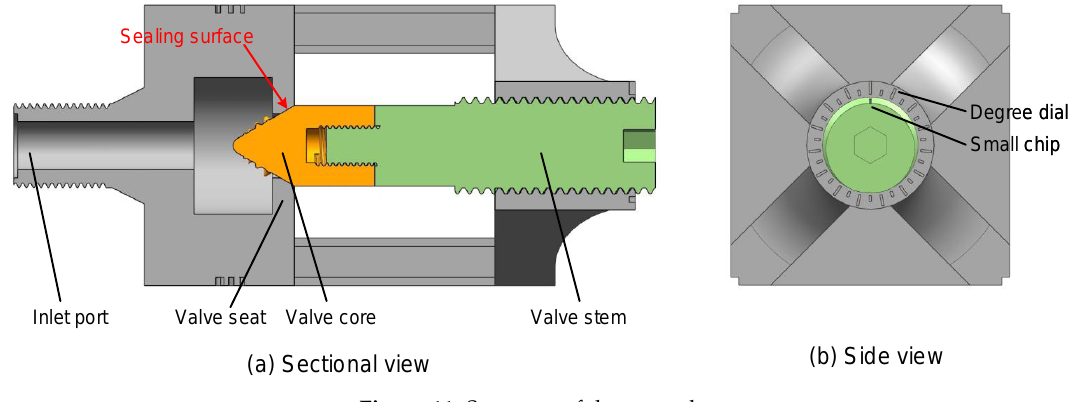
Figure 11. Structure of the test